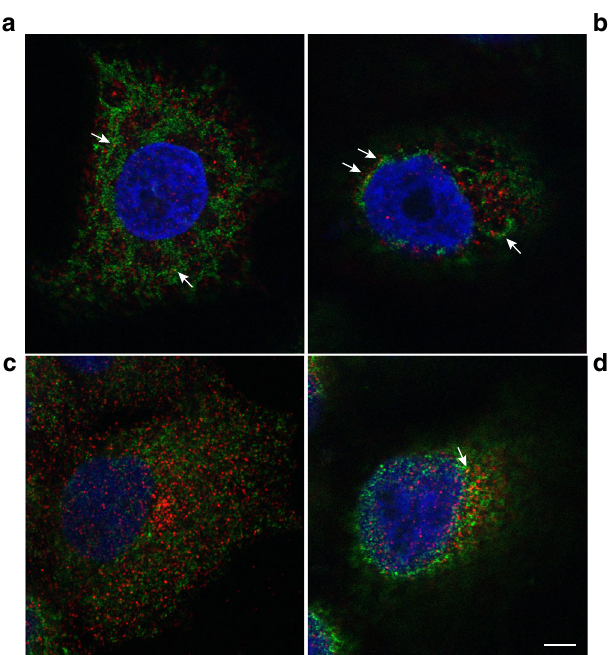
Fig. 5 Localization of Rab11 and PDI in WSN-infected A549 cells. a , b Immuno fl uorescence and confocal microscopy images of two A549 cells (one optical section per cell) infected with the WSN virus and labeled at 8 hpi with antibodies speci fi c for Rab11 (red) and the ER marker PDI (green). c , d Two optical sections of a control mock-infected cells. Arrows point to co-localization spots. Scale bar, 5 μ m